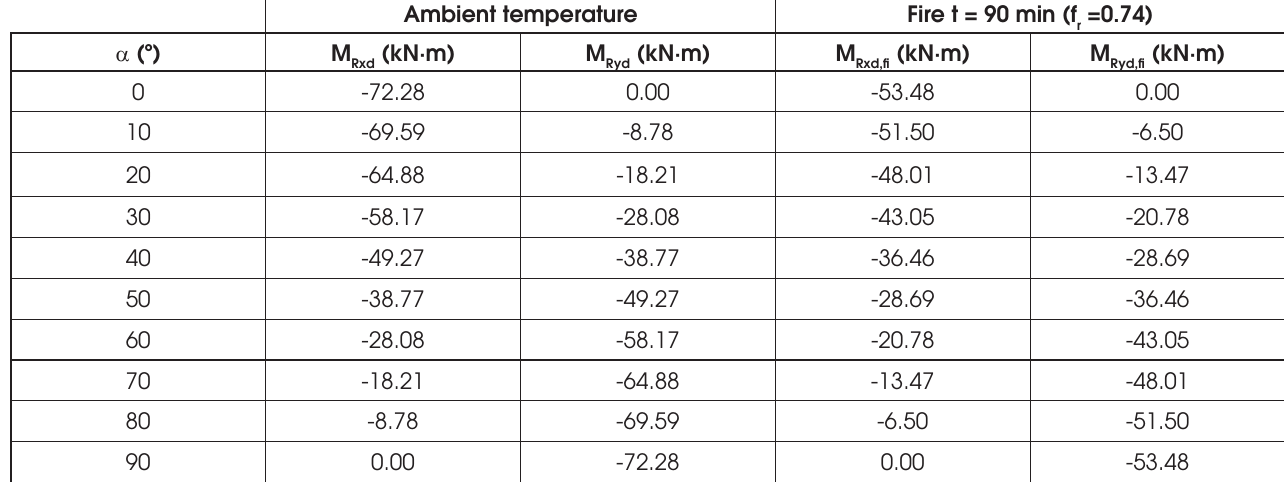
Table 7 ULS assessment on fire from ULS at ambient